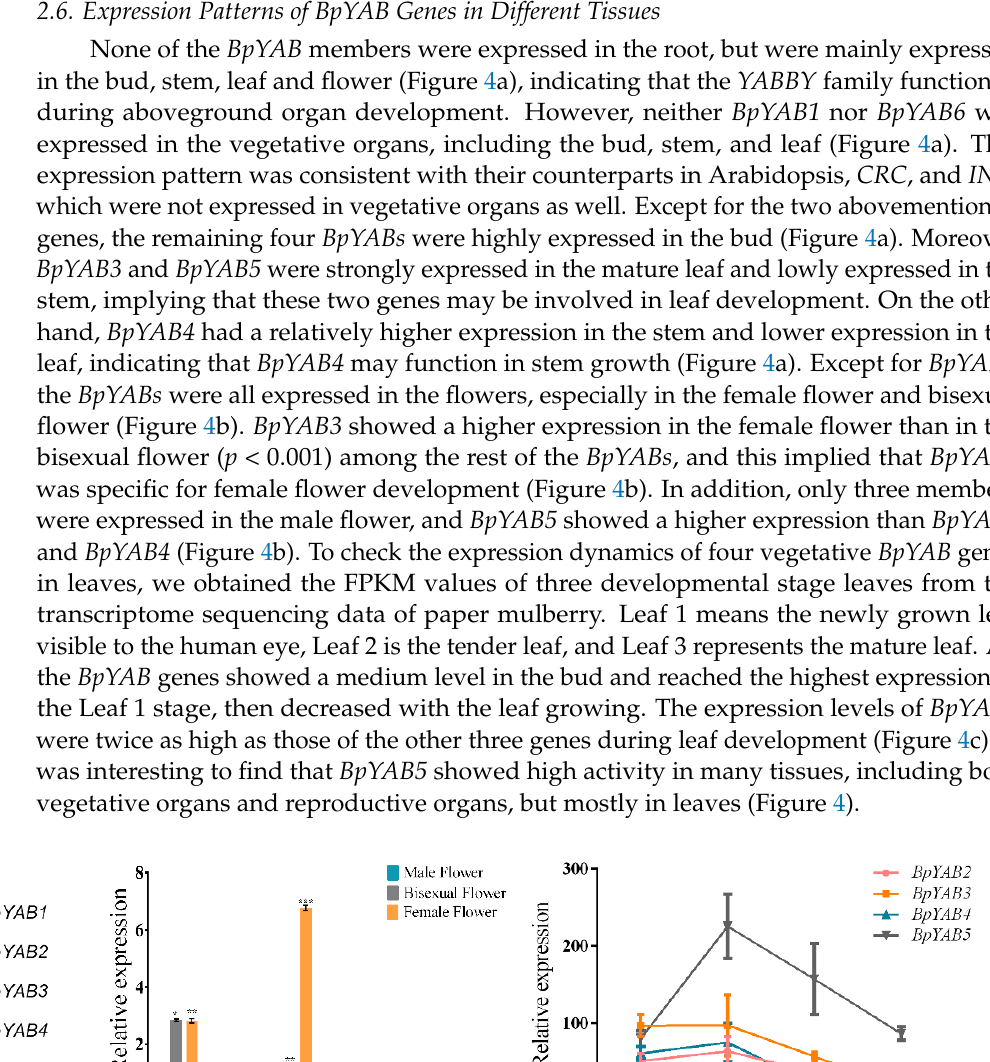
used as a control. From left to right, the images show the green fluorescent field, bright field, and overlap of two illuminations. Bar = 50 µm.